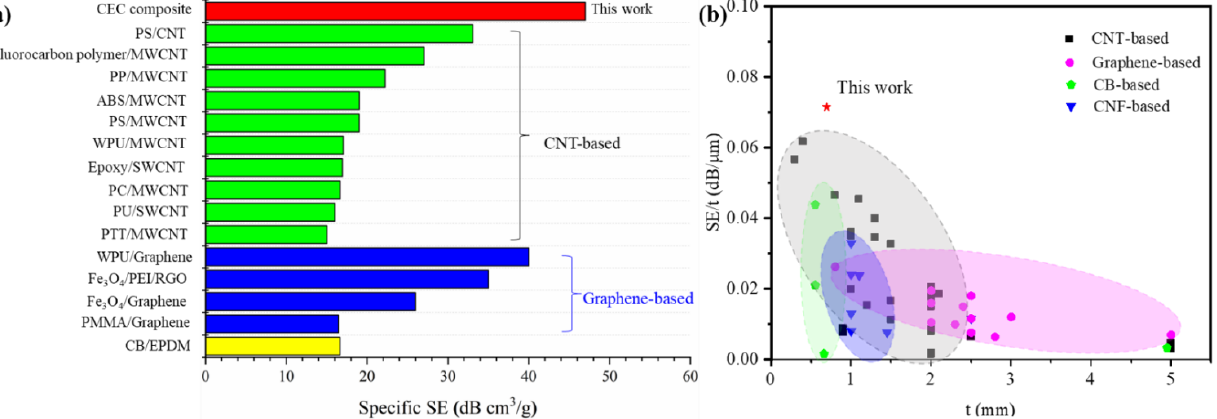
Figure 5. Comparison of EMI shielding performance of different composites: ( a ) specific SE (PS/CNT [27], fluorocarbon polymer/MWCNT [28], PP/MWCNT [25], ABS/MWCNT [29], PS/MWCNT [30], WPU/MWCNT [31], epoxy/SWCNT [32], PC/MWCNT [8], PU/SWCNT [33], PTT/MWCNT [34], WPU/Graphene [35], Fe 3 O 4 /PEI/RGO [36], Fe 3 O 4 / Graphene [37], PMMA/Graphene [38], CB/EPDM [39]); ( b ) SE/t (the detailed shielding effective and thickness of each shielding composite and references are supplied in Supplementary Materials).